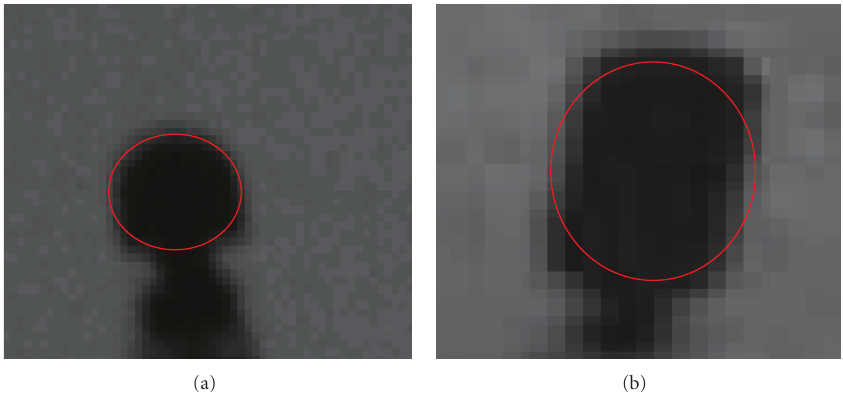
Figure 4: The tip-electrode of an ablation catheter approximated as a disk